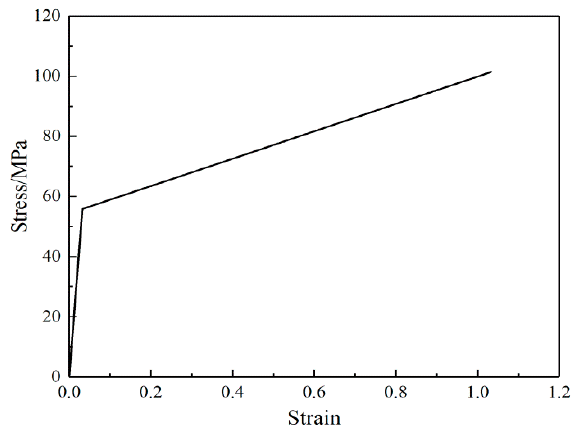
Figure 13. Stress-strain curve of single fiber.